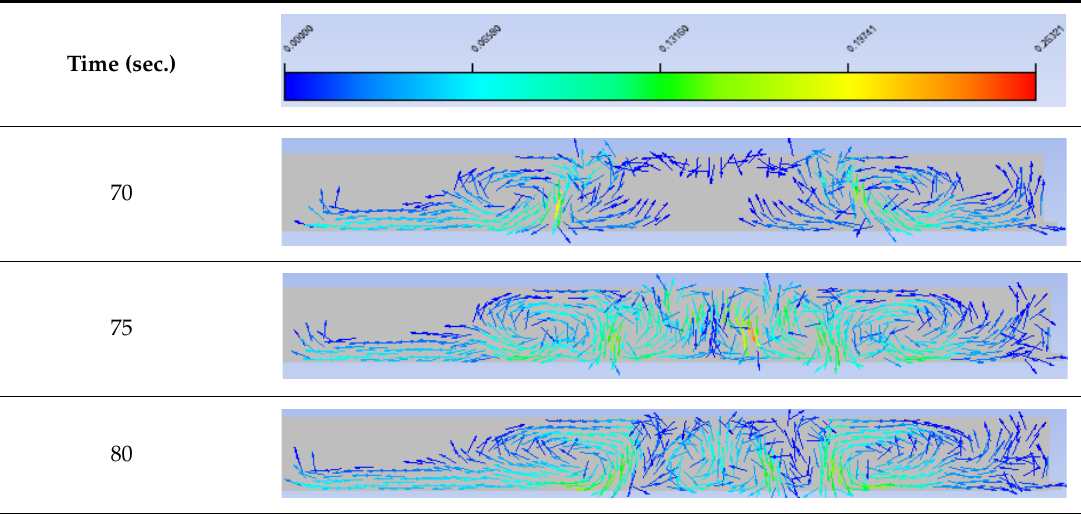
Table 7 Velocity Vector Contours for 500 μm Droplets (m/s).